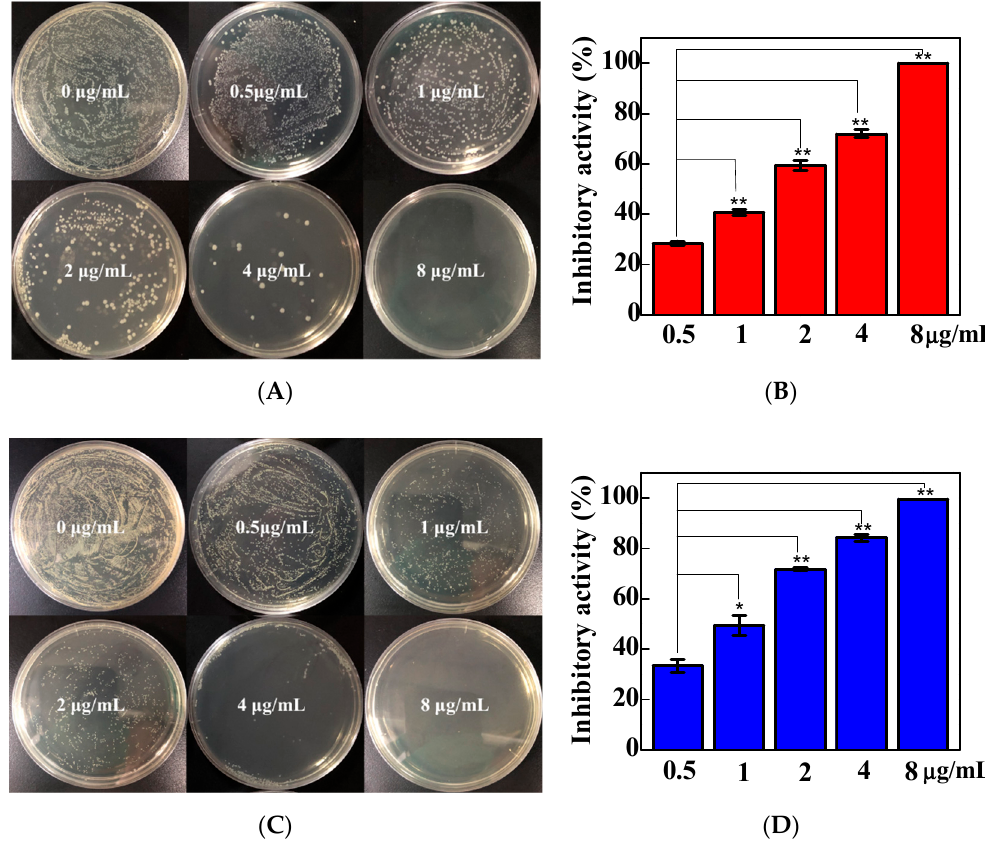
Figure 4. Images of Escherichia coli ( A ) and Staphylococcus aureus ( C ) on TSA plates after 24 h of incubation after treatment with different concentrations of TC/PG nanocomposites, and the corresponding inhibition activity against E. coli ( B ) and S. aureus ( D ).